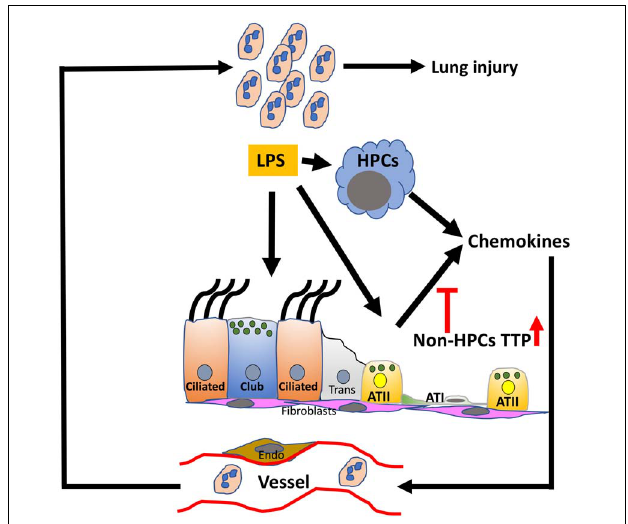
FIGURE 7 | Conceptual model depicting the role of TTP in ALI. The resident cells, myeloid and epithelial, in the lung airspaces respond to the exposure of endotoxin, i.e., LPS. LPS-induced synthesis of chemokine production in the resident cells is modulated via TTP-dependent post-transcriptional regulation in a cell-specific manner. The current study suggests that enhanced TTP expression in non-hematopoietic progenitor cells (HPCs) suppresses the release of neutrophil chemoattractants and protects against ALI. Non-HPC populations include airway (Ciliated, Club, subepithelial cells) and alveolar type I and II cells (ATI and ATII), endothelial cells (Endo), and fibroblasts (fibro); TTP, tristetraprolin; LPS, lipopolysaccharide.